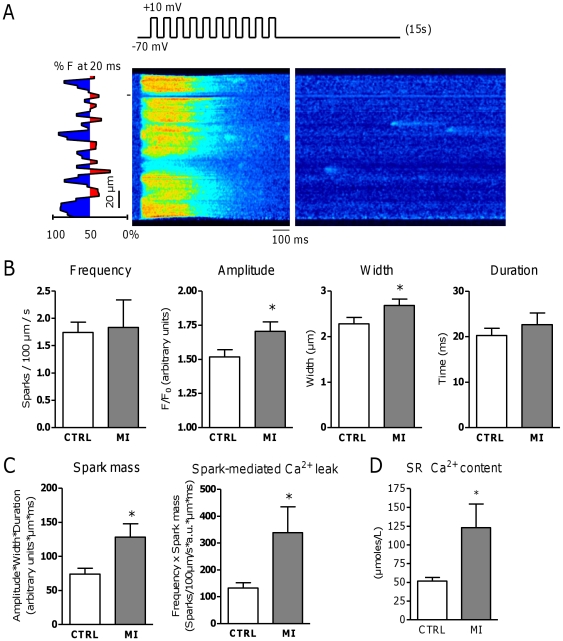
Effect of remodeling in the area adjacent to MI on Ca2+ sparks.A. Representative line scan image of Ca2+ spark recording in MI. The types of release areas are marked in blue and red for early and delayed release areas respectively. The artifact region (marked by –) was excluded for analysis. B. Whole-cell spark frequency and morphology in CTRL (Npigs = 12, ncells = 41) and MI (Npigs = 7, ncells = 33). C. Spark mass, calculated by amplitude*width*duration, and spark-mediated Ca2+ leak, calculated by spark frequency*spark mass, in CTRL (Npigs = 12, ncells = 41) and MI (Npigs = 7, ncells = 33). D. SR Ca2+ content as µmoles/L accessible cytosol, in CTRL (Npigs = 4, ncells = 15) and MI (Npigs = 4, ncells = 12). * denotes P<0.05.